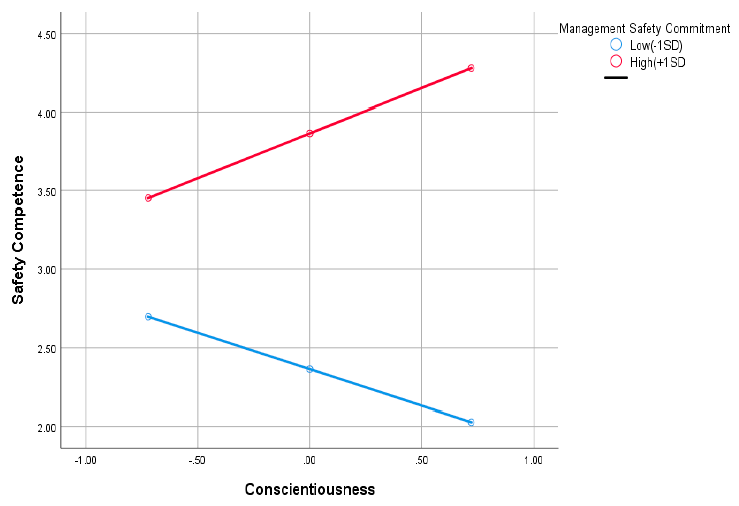
Figure 2. The moderation effect of management safety commitment on the relationship between conscientiousness and safety competency.